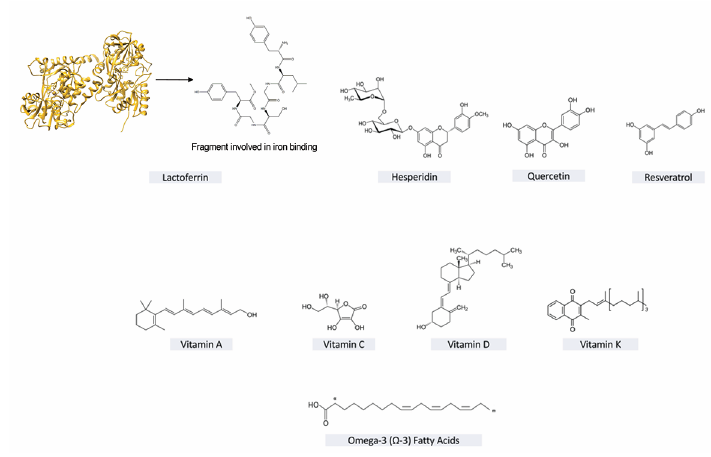
Figure 1. Nutraceuticals’ chemical